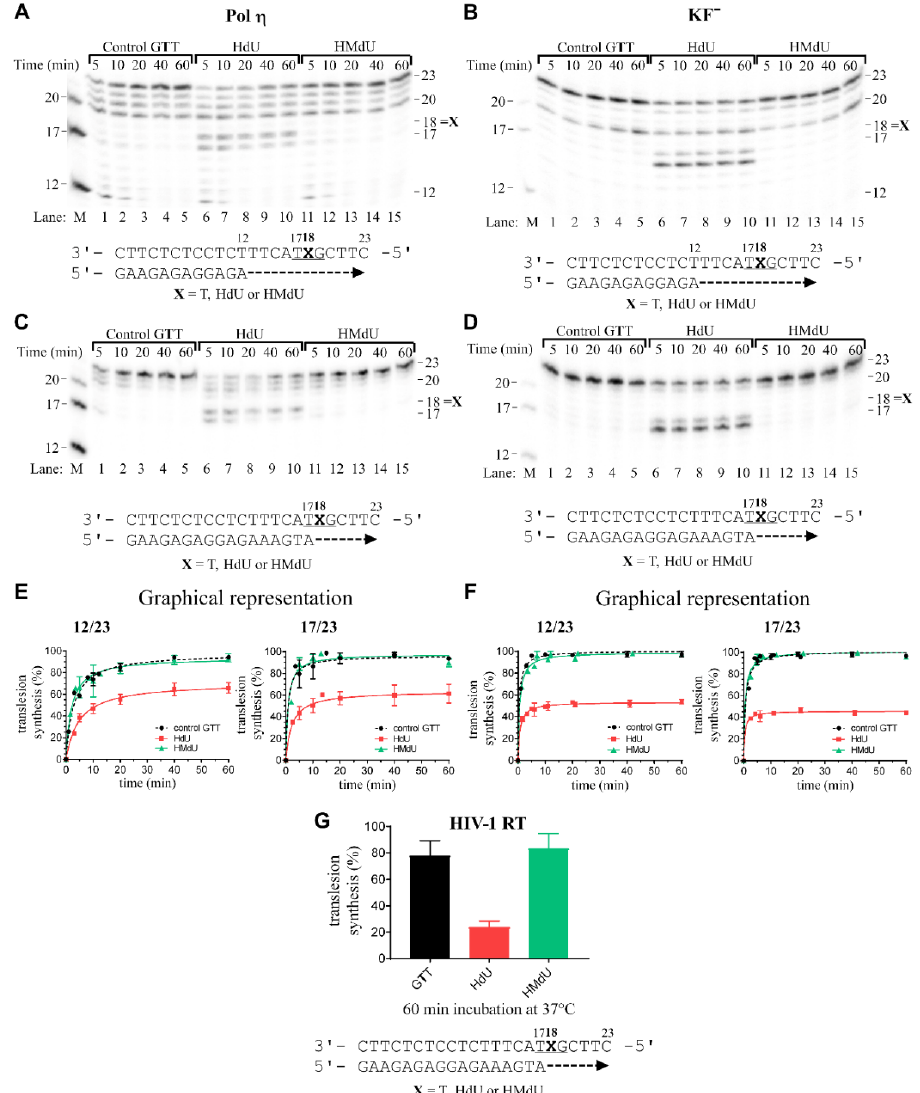
Figure 3. Translesion DNA synthesis by human DNA polymerase η (pol η ), the exonuclease-deficient Klenow fragment of DNA polymerase I (KF – ), and reverse transcriptase from human immunodeficiency virus type 1 (HIV-1 RT) on templates containing a site-specific thymine lesion. Primer extension activity of pol η (A, C, E), KF – (B, D, F), and HIV-1 RT (G). ( A , B , C , D ) Representative images of the products of DNA polymerases reactions resolved on 15% polyacrylamide (PAA) gels. 12mer (gap-primer for “running start” experiments) or 17mer (no gap-primer for “standing start” experiments) DNA primers were complementary to the 3’ termini of the 23mer templates. The experiments were conducted using the 12-mer/23-mer (panels A , B ) or 17-mer/23-mer primer/template duplexes (panels C , D ) for the various times (time points of 5–60 min are shown above the gels) using undamaged template (panels A , B , C , D , lanes 1–5), the template containing HdU or HMdU instead of thymine at the 5′ -G X T sequence (panels A , B , C , D , lanes 6–10 or lanes 11–15, respectively). The pause sites and position of thymine modification (the product lengths) are shown on the right side of the gels. Lane M: DNA markers. The nucleotide sequences of the templates and the primers are shown at the bottom of panels A , B , C , D , and G . ( E , F ) Densitometric evaluations of the amount of synthesis past undamaged or modified templates. Left panels: “Running-start” synthesis. Right panels: “Standing-start” synthesis. The graphs show the time dependence of the inhibition of DNA synthesis on undamaged (control) template (full circles), DNA containing HdU (full squares), and DNA containing HMdU (full triangles). Translesion DNA synthesis by HIV-1 RT is plotted in graph G for the “steady-state” after 60 min incubation. Data are means ( ± SEM) from three di ff erent experiments. For some points, the error bars are smaller than the size of the